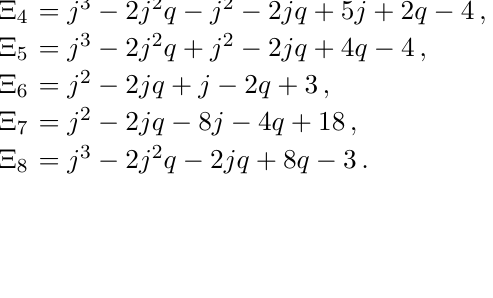
( j 1) ; 0). The unbarred entries in the j = 2 column are 2 (cid:0)